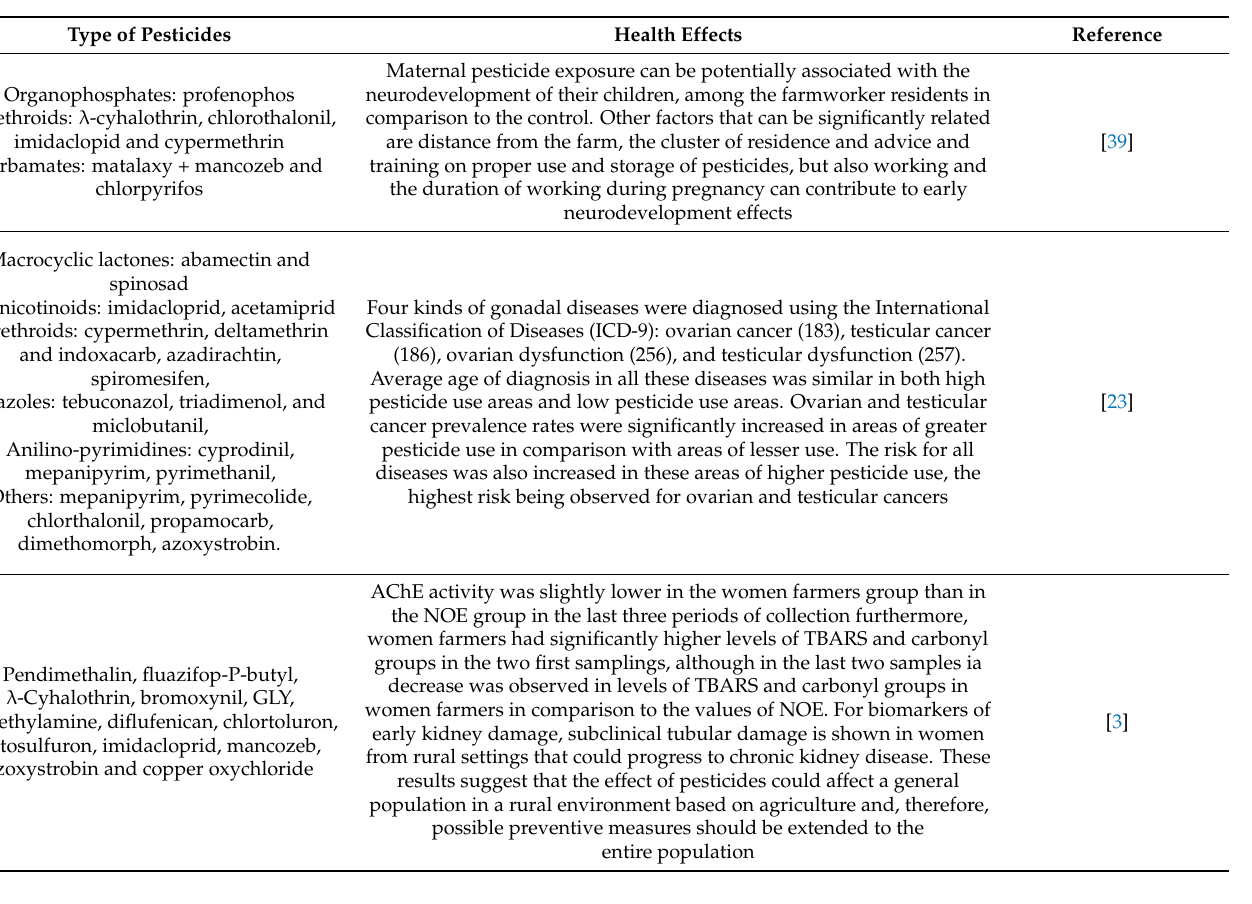
Table 4. Studies of impact of pesticides exposure on womens’